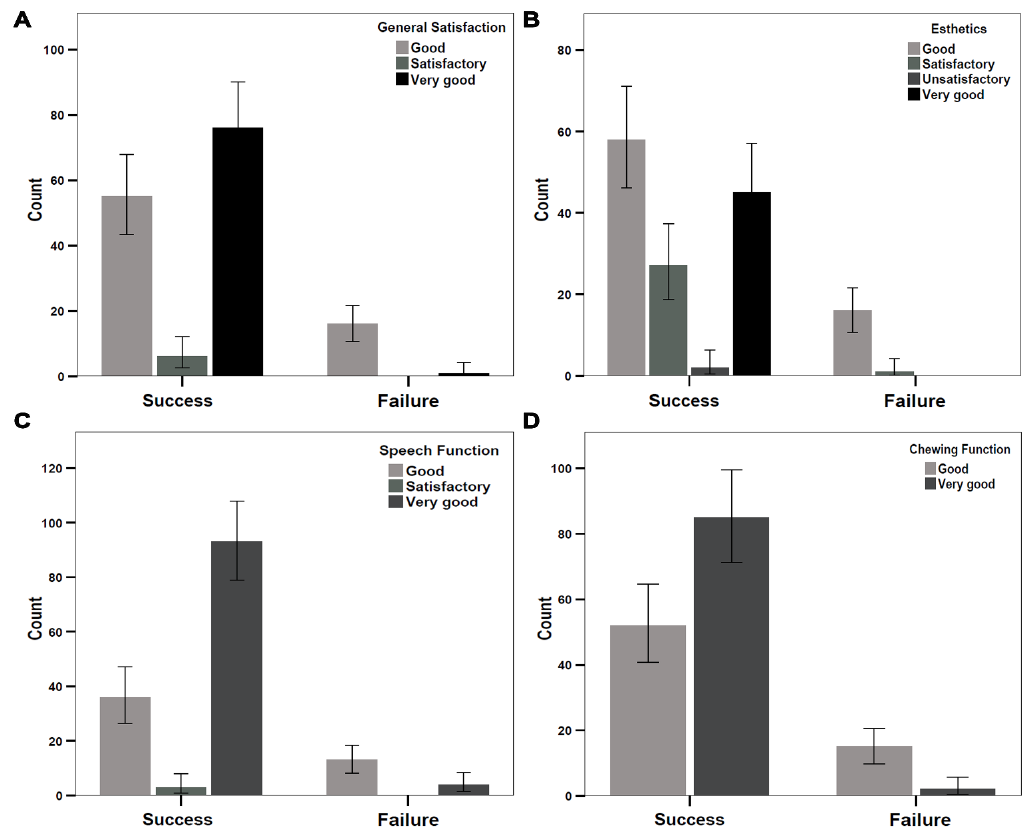
Figure 6. Frequency analysis revealed the implant success level in patients after rehabilitation.